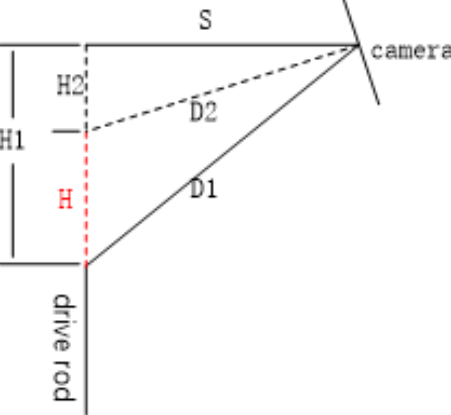
Figure 9. Schematic diagram of drive-lever height difference.